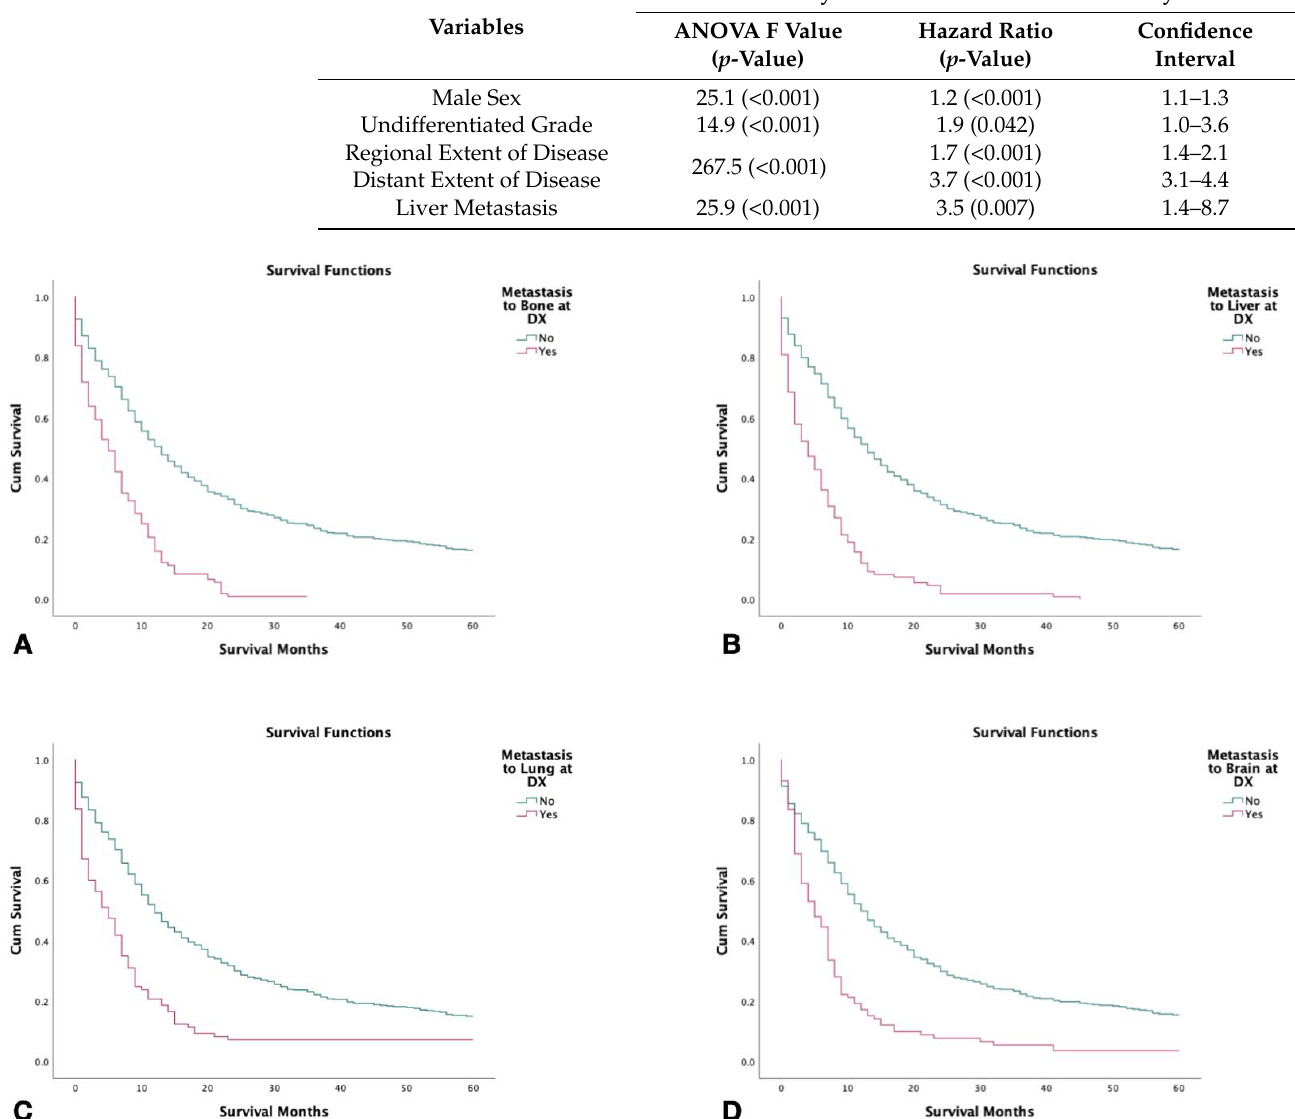
Table 6. Multivariate Analysis of Independent Factors Affecting 2126 Patients with Combined Small- Cell Lung Cancer from Surveillance Epidemiology and End Result (SEER) Database (2000–2018).